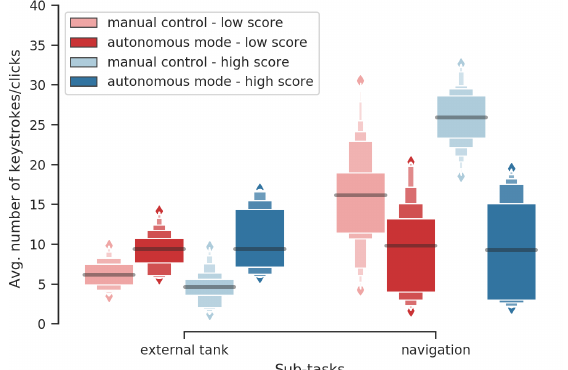
Figure 6. Average number of keystrokes/clicks per sub-task (filling the external tank and driving the robot) during autonomous mode and manual control given performance groups. These graphical representations reappear in the next figures. They show a large number of quantiles, which makes it easier to visualize nonparametric